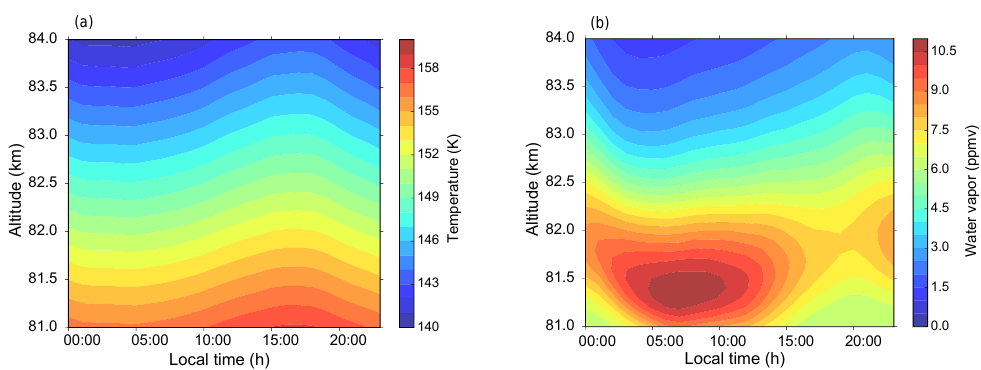
Figure 1. Local time variation derived from monthly and zonal means of temperature (a) and water vapor (b) in the latitude band 67–71 ◦ N for July 2009; see text for more